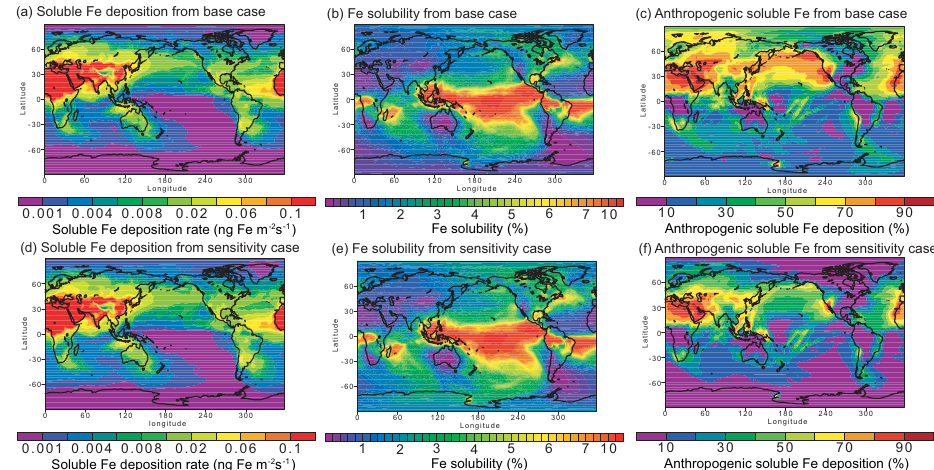
Figure 7. Deposition of soluble Fe (ngFem − 2 s − 1 ) from dust and combustion sources to the oceans in the present day (a) from base simula- tions and (d) from sensitivity simulations, Fe solubility in the present day (b) from base simulations and (e) from sensitivity simulations, and ratio of increase from the preindustrial era to present day to soluble Fe deposition in the present day (c) from base simulations and (f) from sensitivity simulations. The formation of the amorphous Fe(OH) 3 (s) suppresses the oxalate-promoted dissolution from mineral aerosols in the base simulations, while no such effect was considered for quasi-light-induced reductive dissolution in the sensitivity simulation (i.e., f 3 = 1).